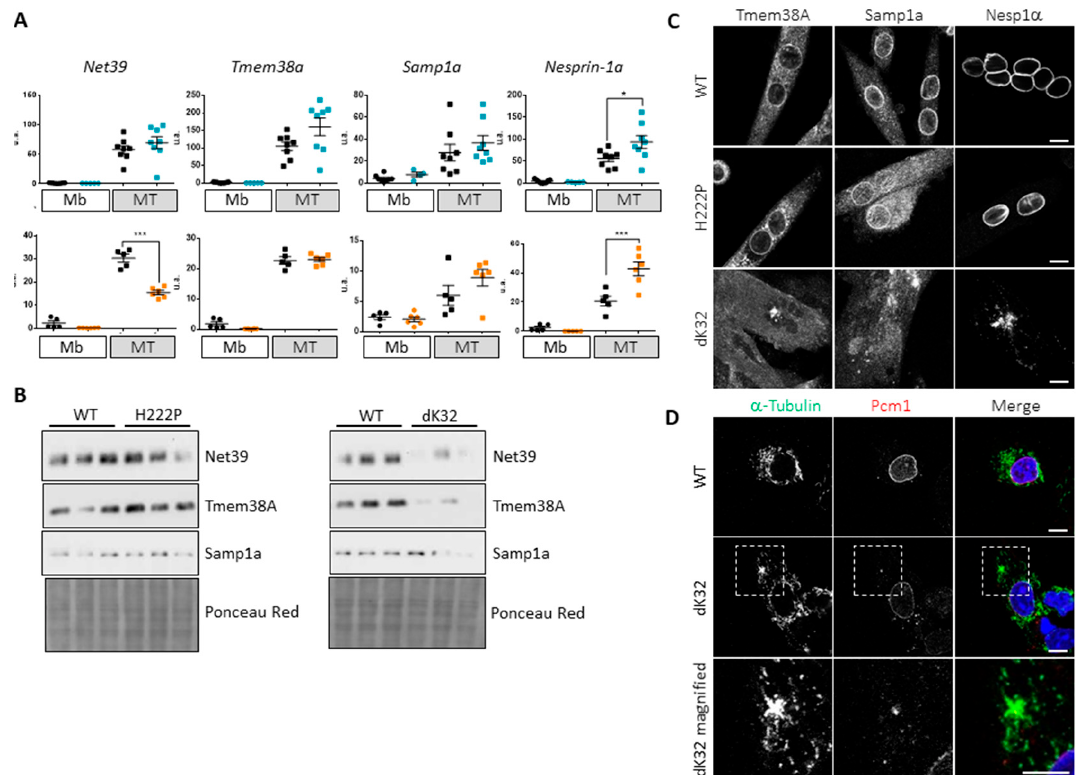
Figure 3. Defective expression and localization of muscle specific nuclear envelope transmembrane proteins (NETs). ( A ) Dot plots showing Net39 , Tmem38A , Samp1a and Nesprin-1 α mRNA expression level in myoblasts (Mb) and four-day differentiating WT (black; at least n = 5), H222P (blue; at least n=5) and dK32 (orange; n = 6) myotubes (MT) normalized to Rplp0 expression. *: p < 0.05; ***: p < 0.001. ( B ) Western blots showing Net39, Tmem38A and Samp1a protein level in four-day differentiated WT and H222P myotubes (left) and WT and dK32 myotubes (right). ( C ) Confocal images showing Tmem38A, Samp1a and Nesprin-1 α (Nesp1 α ) immunostainings in WT, H222P and dK32 four-day differentiated myotubes. Bar graph: 10 μ m. ( D ) Confocal images showing α -Tubulin and Pcm1 immunostaining in WT and dK32 myoblasts five min after Nocodazole washout. The monochrome pictures are presented in color (green: α -Tubulin; red: Pcm1) overlaid with DAPI (blue) on the right. A magnification of the area surrounded with white dotted line on dK32 is shown on the bottom panel. Bar graph: 10 μ m.